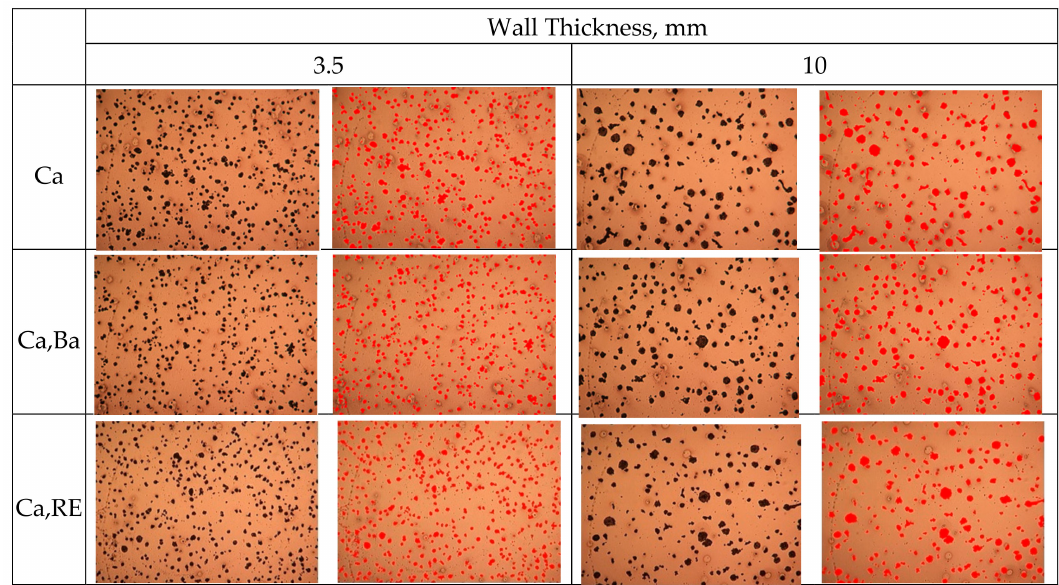
Figure 3. Micro-structures of inoculated (Ca / Ca, Ba / Ca, RE) ductile cast irons at 3.5 and 10 mm wedge casting thickness (70 X).